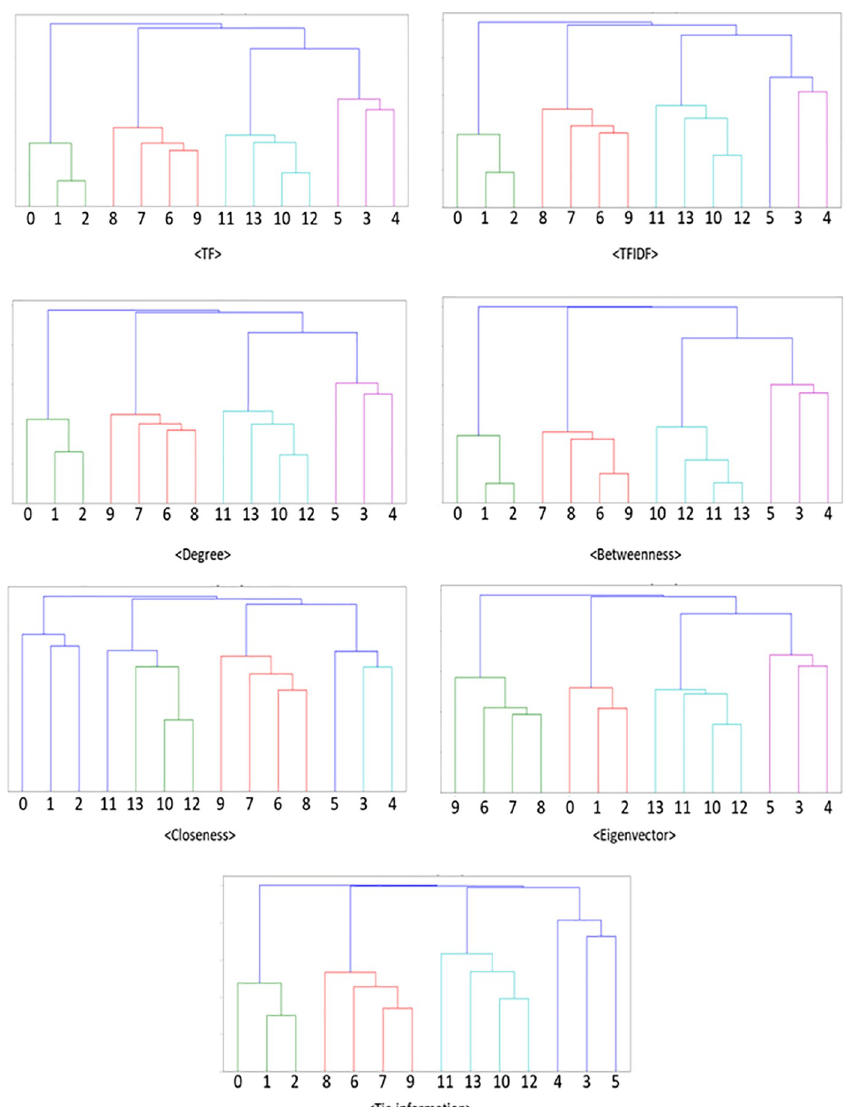
Fig 4. Dendrogram plots of the hierarchical clustering analyses. Note : Horizontal axis: Document ID, Vertical axis: Distance. “linkage” parameter, we use the “average” option, and for the “affinity” parameter, we used